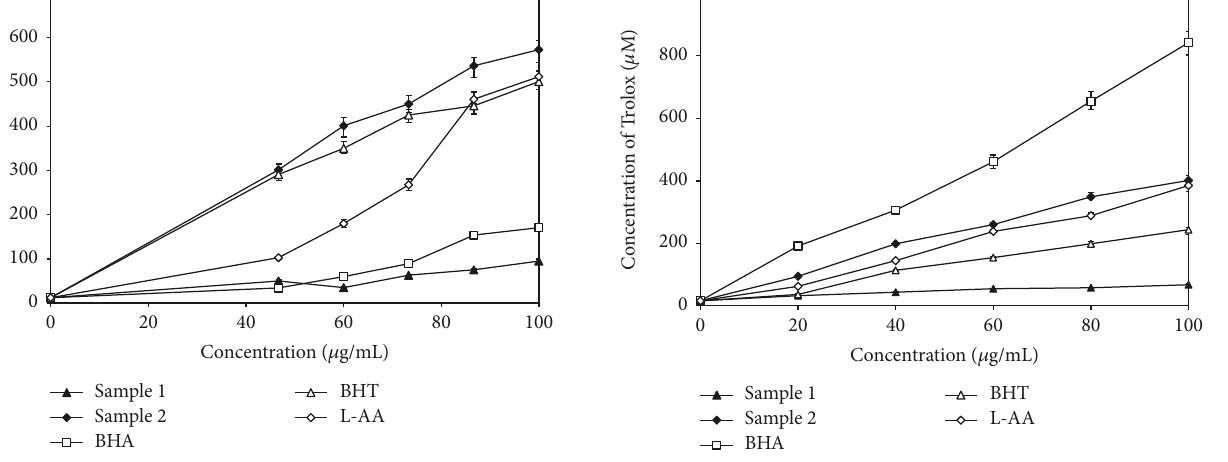
Figure 4: Antioxidant activity of extracts from the sarcocarp of C. multiflorus pluspositivecontrolsbyusingFRAPmethod.Resultsare mean ± SD ( 𝑛 = 3 ). Sample 1: the sample extracted by ethanol-water (7 :3, v/v); Sample 2: the sample reextracted from Sample 1 by ethyl